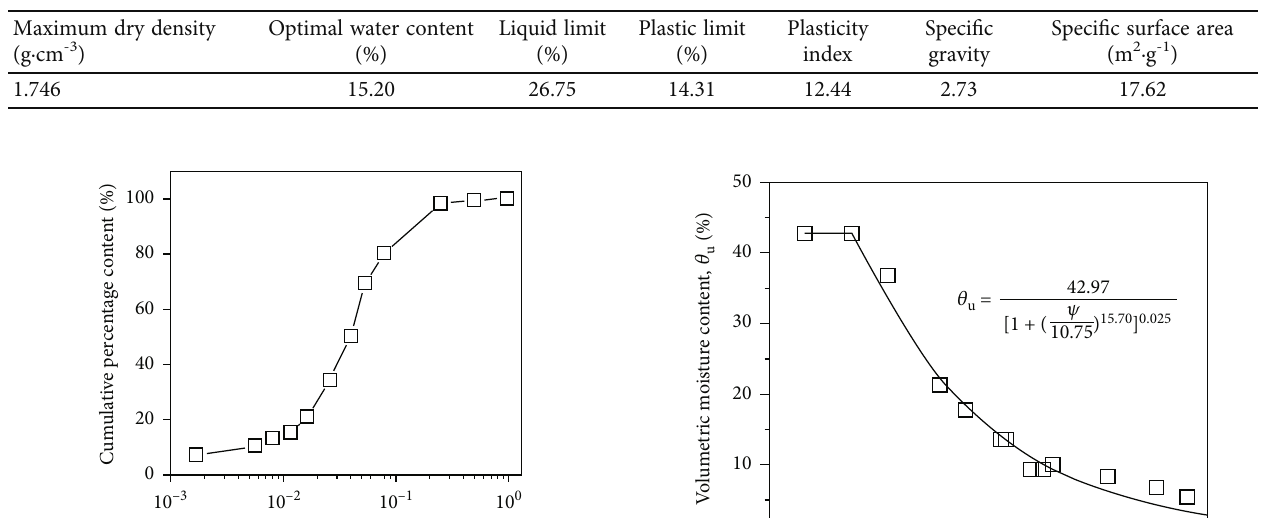
Table 1: The basic physical parameters of the Qinghai silty clay.